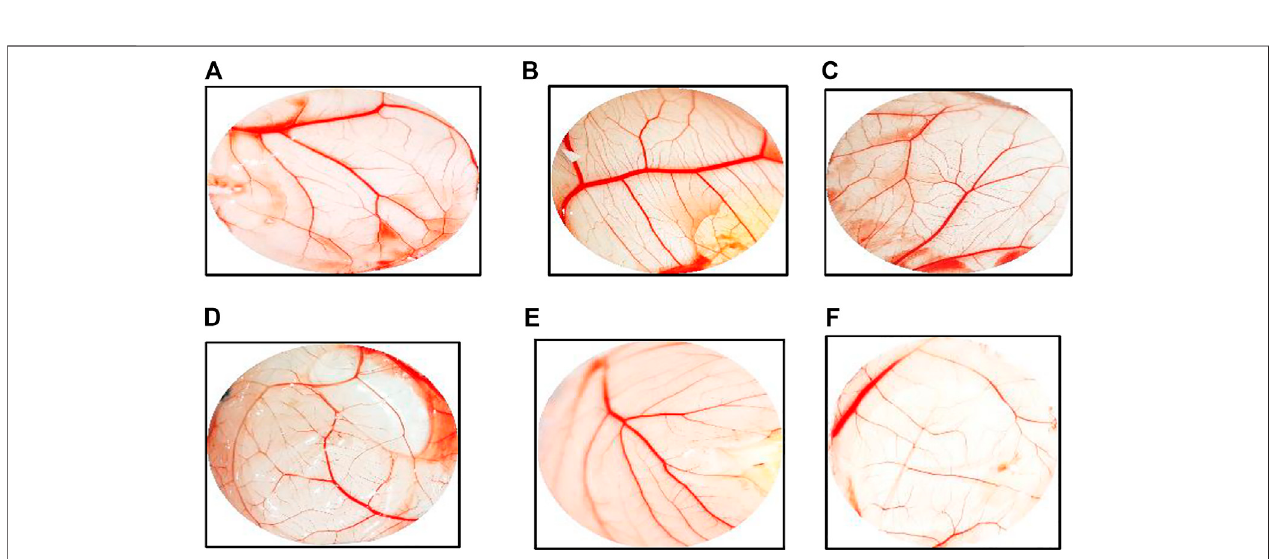
FIGURE 9 | Angiogenesis parameter quantitative of ZnO nanorods (ZnO-NRs) and released zinc (II) ions using chicken chorioallantoic membrane (CAM) assay.